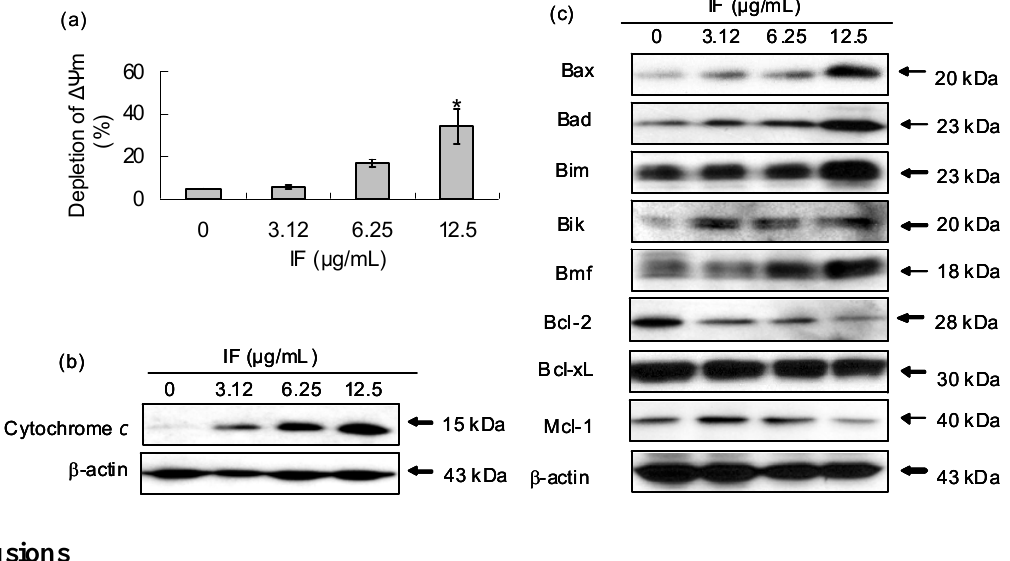
Figure 5. Effect of IF on mitochondria and the related protein expression in CNE cells at 72-h treatment. (a) Effect of IF on mitochondrial membrane potential ( ΔΨ m). Each value represents the mean of three independent experiments. Difference between treatments and control with p < 0.05 (*) was considered statistically significant. (b) The level of cytochrome c in the cytosol. (c) Effect of IF on the expression of Bcl-2 family proteins. β - actin was used as the loading control. Results were representatives of three independent